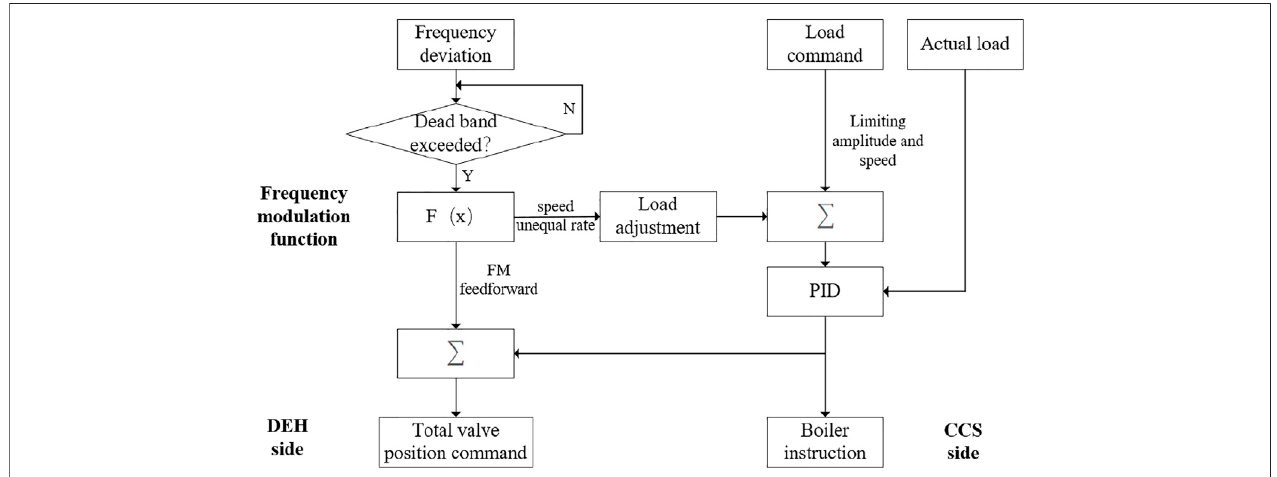
FIGURE 2 | Typical PFM control